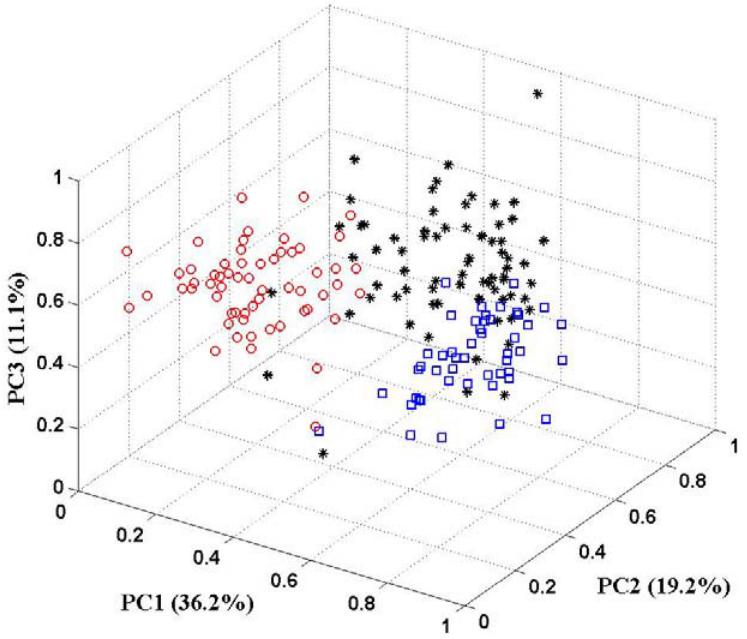
Figure 5. The 3D-PCA plot of three classes of wine derived from three different cultivars.